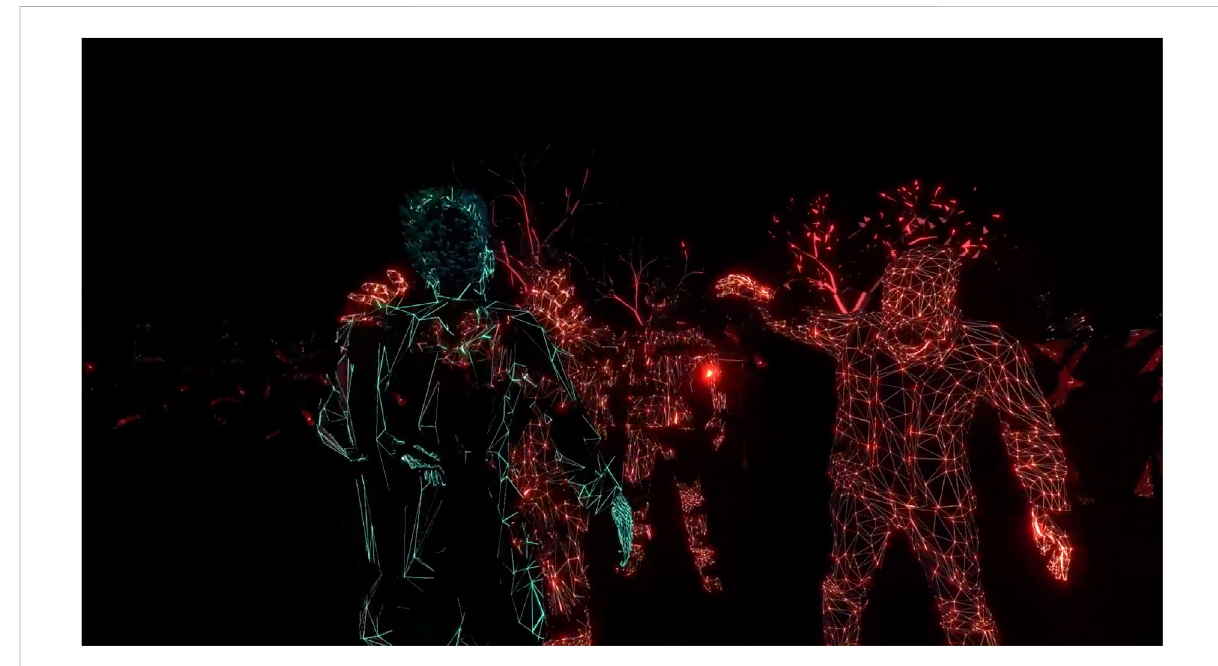
FIGURE 1 Screen capture of characters interacting as shown in trailer video of “ Stress Management and Civil Unrest ” VR experience by Head Set. Video available from